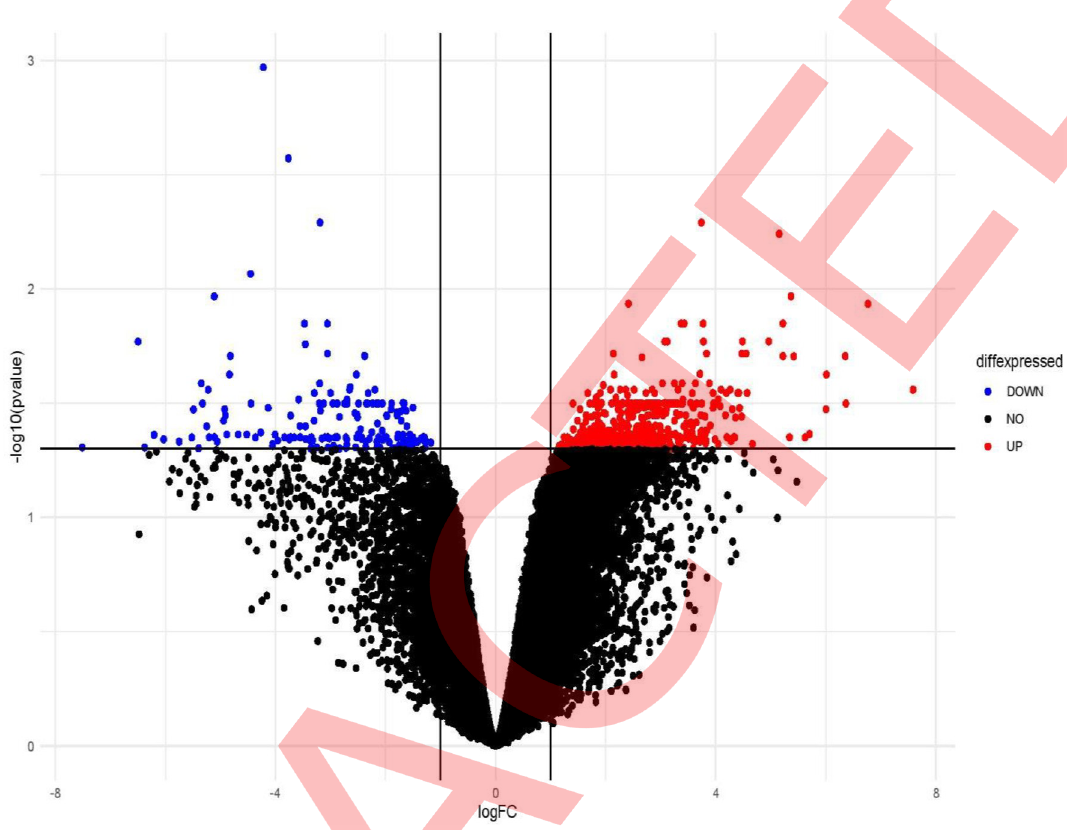
Fig 1. Representation of differential expressed genes in form of Volcano plot with red dots showing upregulated genes while blue dots showing downregulated genes. Black dots represent non-significant genes.